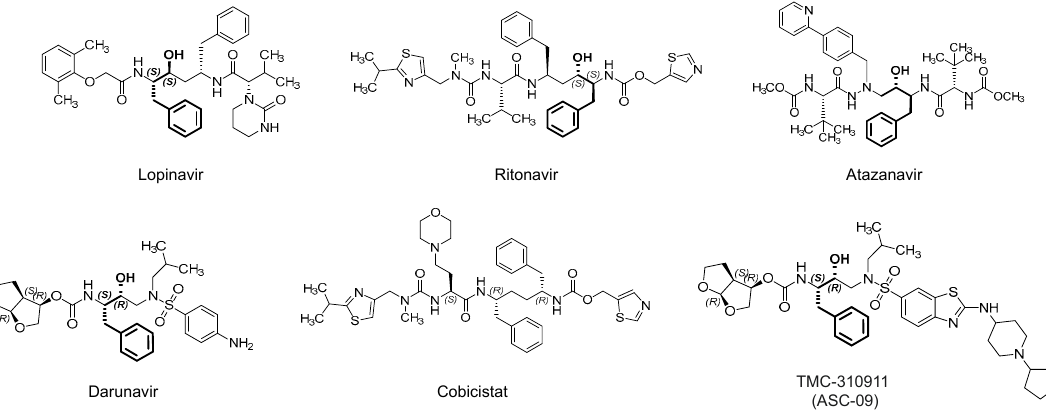
Figure 6. Chemical structures of HIV-1 aspartate protease inhibitors (except cobicistat) that are currently being tested as potential inhibitors of proteases relevant to SARS-CoV-2. Ritonavir and cobicistat are pharmacokinetic boosters. The most frequent tested combination in COVID-19 patients is lopinavir/ritonavir.